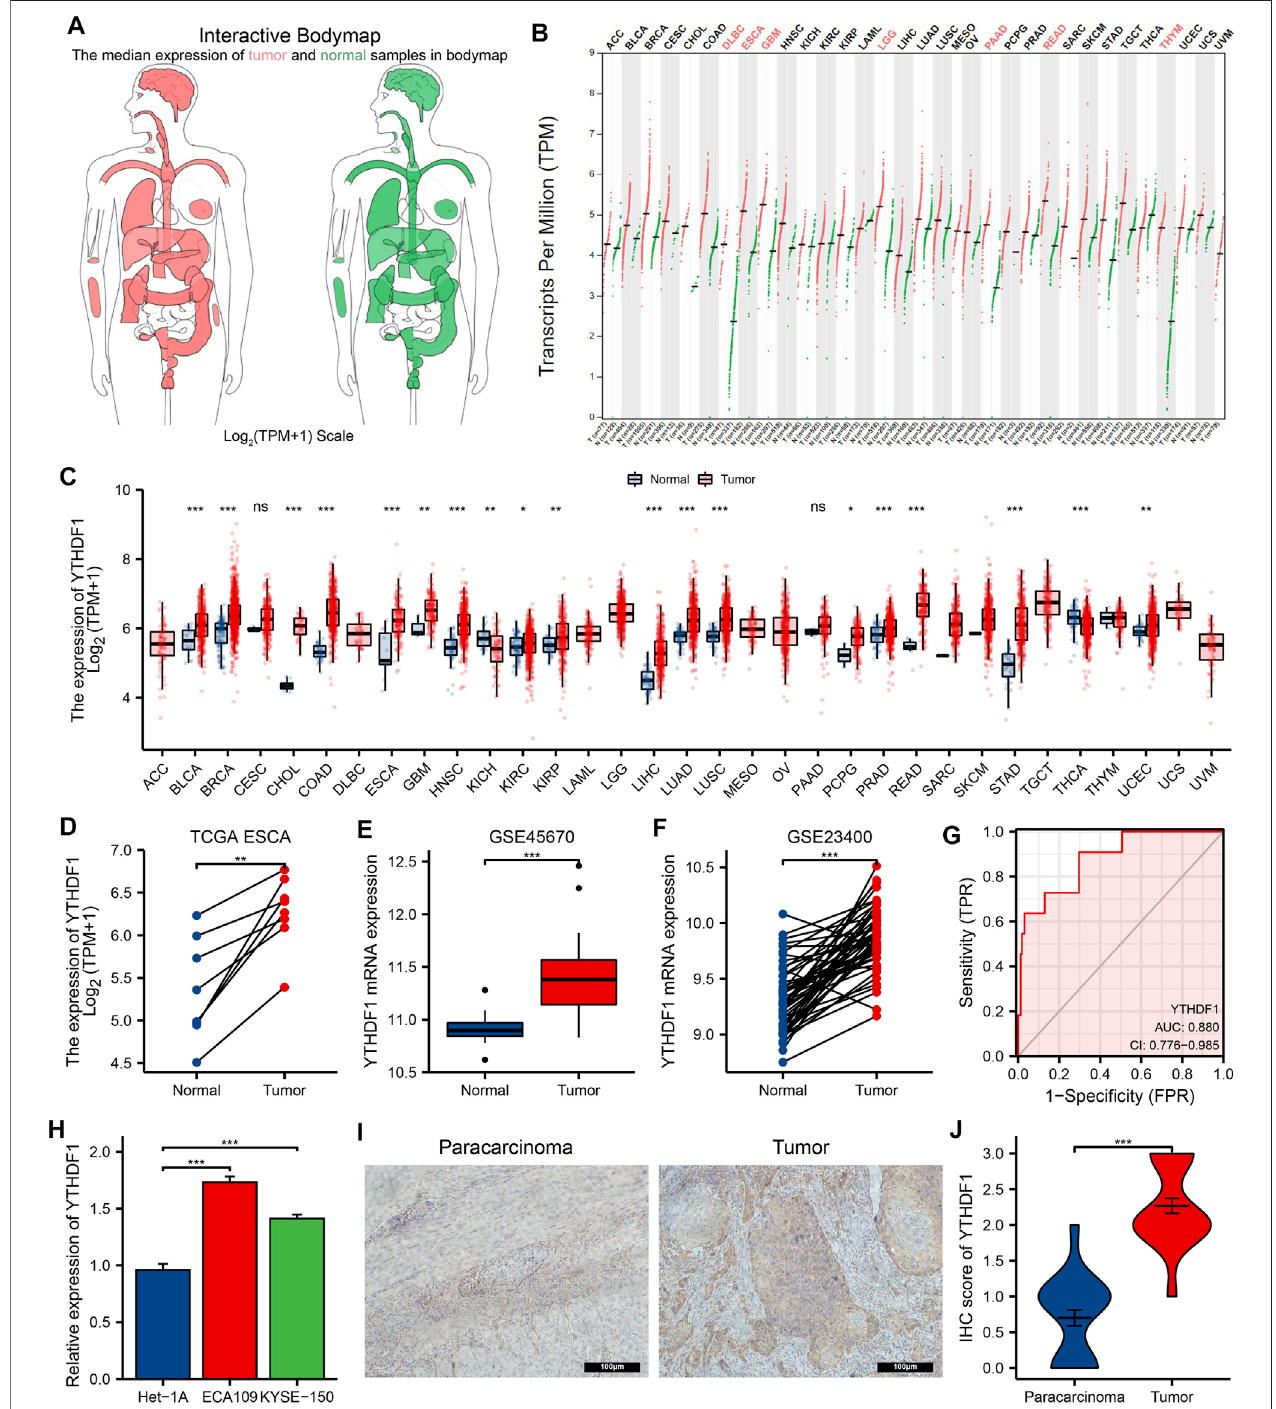
FIGURE 2 | The expression of YTH N6-methyladenosine RNA-binding protein 1 (YTHDF1) in esophageal carcinoma (ESCA) and pan-cancer. (A) Body map of YTHDF1 in Gene Expression Pro fi ling Interactive Analysis (GEPIA), red represents YTHDF1 in tumor specimens and green represents YTHDF1 in normal specimens. A darker color indicates a higher gene expression level. (B) YTHDF1 expression of tumor and normal tissues in GEPIA. (C) The Cancer Genome Atlas (TCGA) cohort summarizestheexpressionofYTHDF1inpan-cancer. (D) ExpressiondifferencesofYTHDF1betweenpairedsamplesinTCGAESCAcohort. (E,F) TheGSE45670 and GSE23400 cohort showed an elevated expression of YTHDF1 in tumor specimens. (G) ROC curve analysis of YTHDF1 diagnosis in ESCA. (H) Difference in expression of YTHDF1 in ESCA cell lines and human normal esophageal epithelial cell lines. (I) The protein expression of YTHDF1 in paracarcinoma and ESCA tissues was estimated by immunohistochemistry. (J) The mean YTHDF1 IHC score was signi fi cantly higher for the ESCA sample than the matched paracancerous sample. * p < 0.05; ** p < 0.01; *** p < 0.001; ns, no signi fi cance.